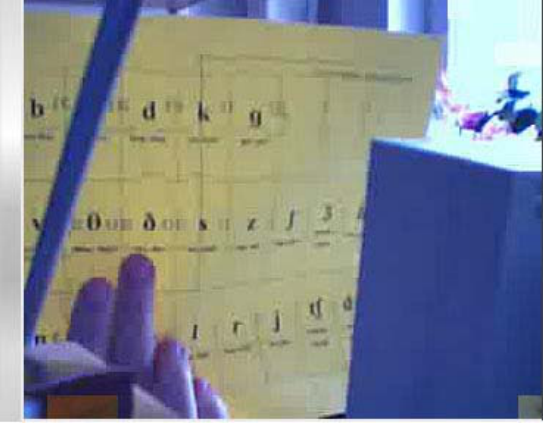
Figure 8 . This is the symbol I